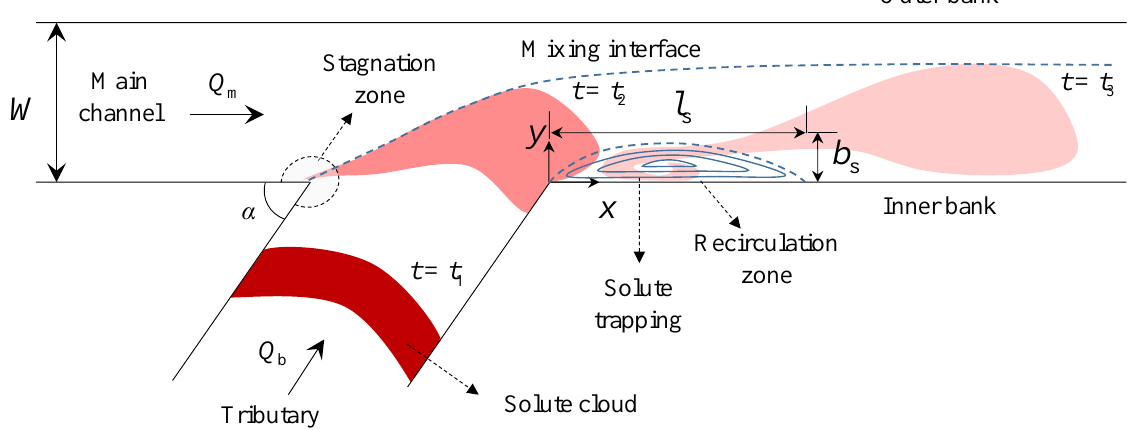
Figure 1. Conceptual diagrams of flow and solute mixing at channel confluence.